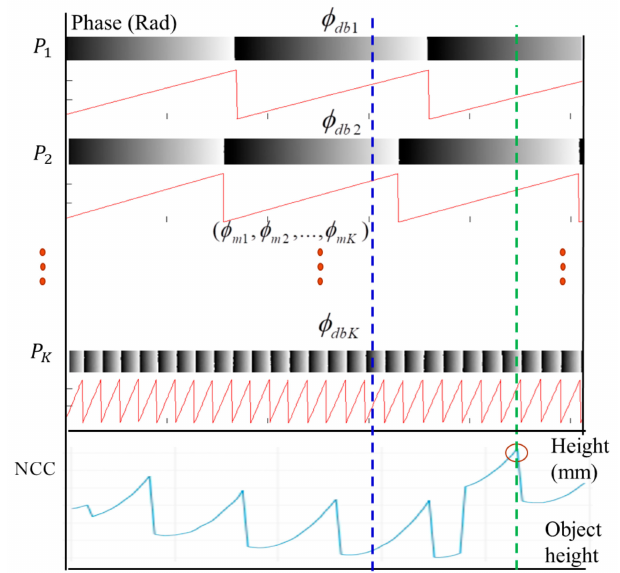
Figure 4. Illustration of the proposed absolute height calibration algorithm for a single measuring pixel.